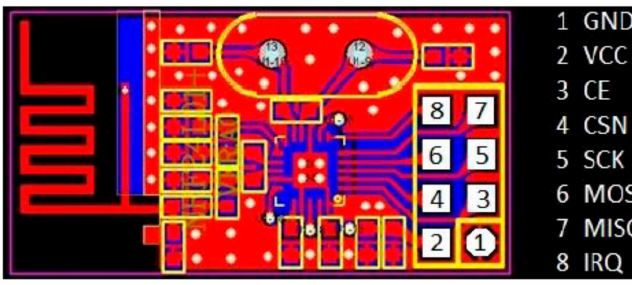
Figure 3. NRF PCB Layout.